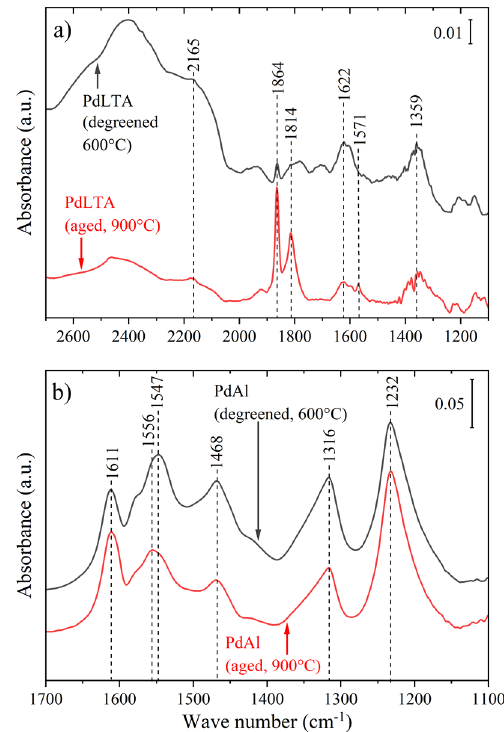
Figure 3. Diffuse reflectance infrared Fourier transform spectroscopy (DRIFTS) spectra collected at 80 °C after 60 min exposure to 200 ppm NO of ( a ) PdLTA and ( b ) PdAl. The spectra are corrected with the sample background which was acquired at 80 °C in Ar prior to the NO exposure. Black lines represent samples degreened at 600 °C and red lines show samples aged for 8 h in O 2 and H 2 O at 900 °C (see Section 3.2.4.).